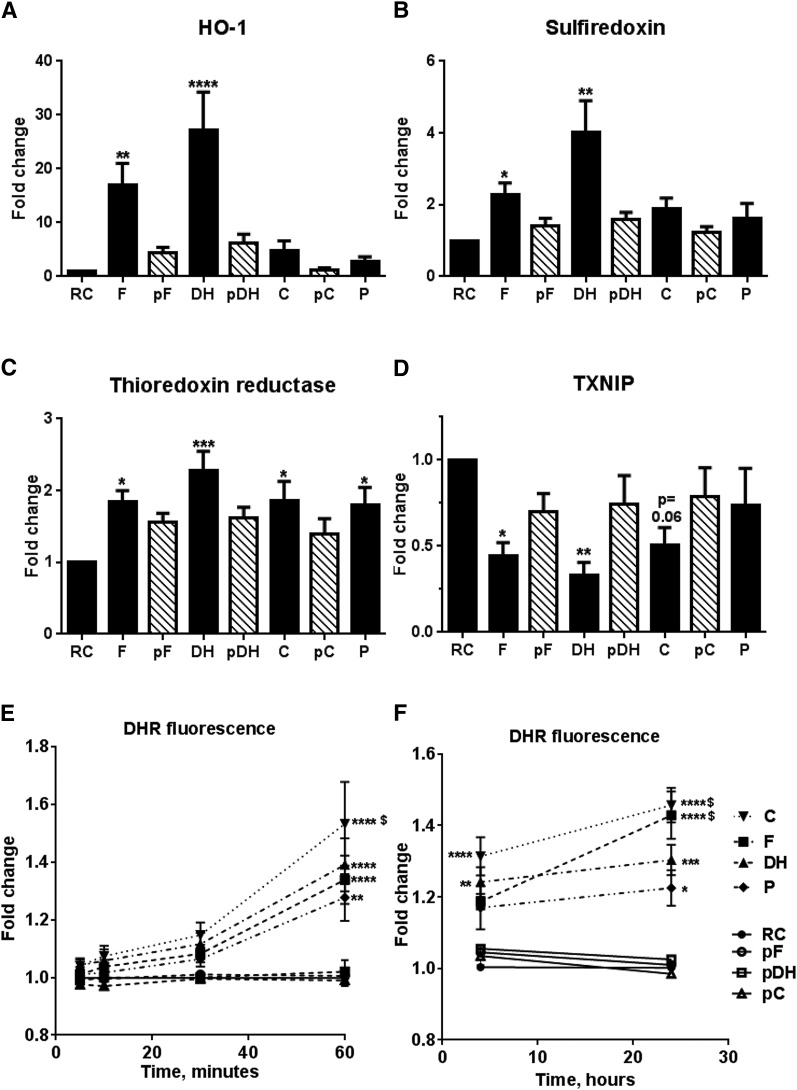
A-CRLPs modulate cytoprotective gene expression and elevate ROS production dependent upon oxidative state. A–D: HAECs were serum starved for 5 h and then incubated with A-CRLPs (280 μM TG) for 4 h. HO-1, SRX, TXR, and TXNIP mRNAs were quantified by qPCR and normalized to GAPDH (mean fold change versus RC ± SEM; n = 4–5. Black bars: remnant control (RC), fish (F), DHASCO® (DH), corn (C), and palm (P) A-CRLPs. Striped bars: probucol-fish (pF), probucol-DHASCO® (pDH), and probucol-corn (pC) A-CRLPs. One-way ANOVA with Dunnett’s multiple comparisons test, compared with RC: *P < 0.05, **P < 0.01, ****P < 0.0001. E, F: DHR was used to measure ROS/RNS production, presented as mean fold change relative to RC ± SEM (n = 6 for A-CRLPs, n = 3 for probucol-A-CRLPs with each experiment performed in technical quintuplet). Two-way ANOVA, RC versus A-CRLPs indicated: *P < 0.05, **P < 0.01, ***P < 0.001, ****P < 0.0001. For palm A-CRLPs versus other compositions, $P < 0.05.